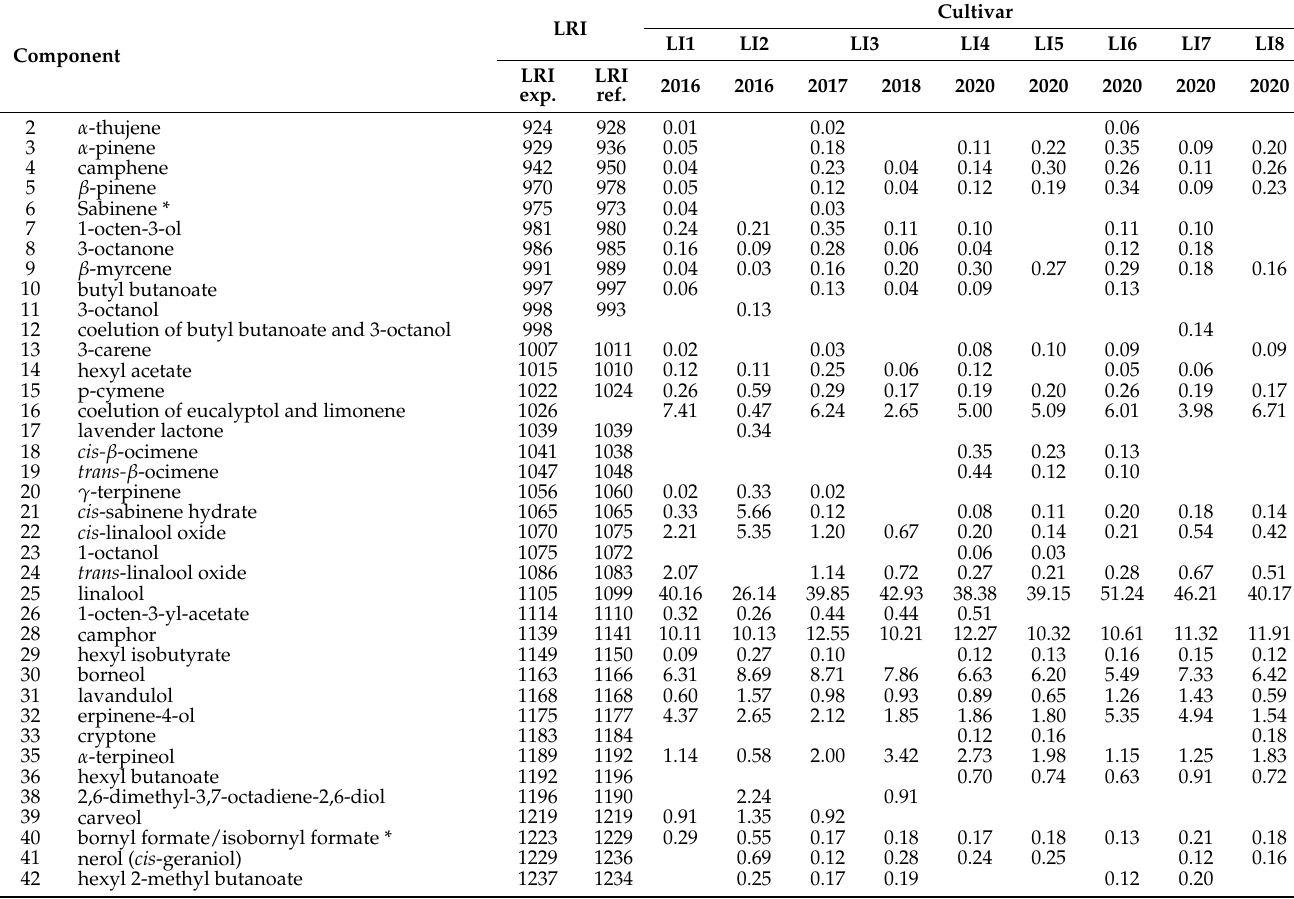
Table 4. Relative abundances (in %) of components in the essential oils obtained in eight new Lavandula x intermedia cultivars (LI1-LI8). * tentative